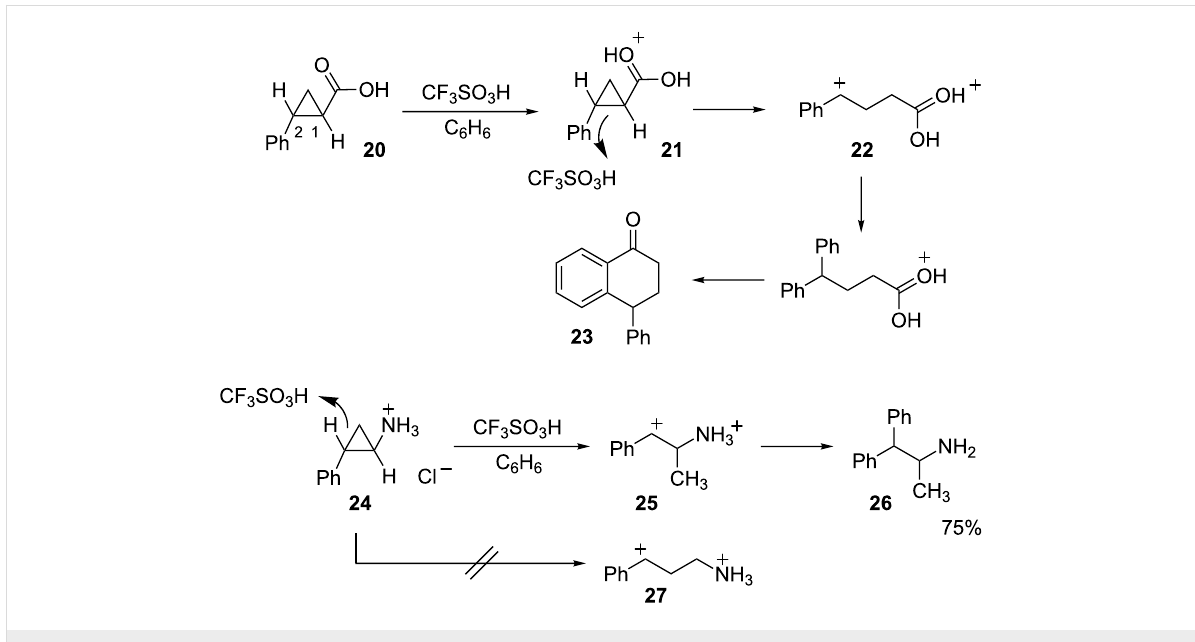
Scheme 4: Ring-opening reactions of cyclopropyl derivatives.